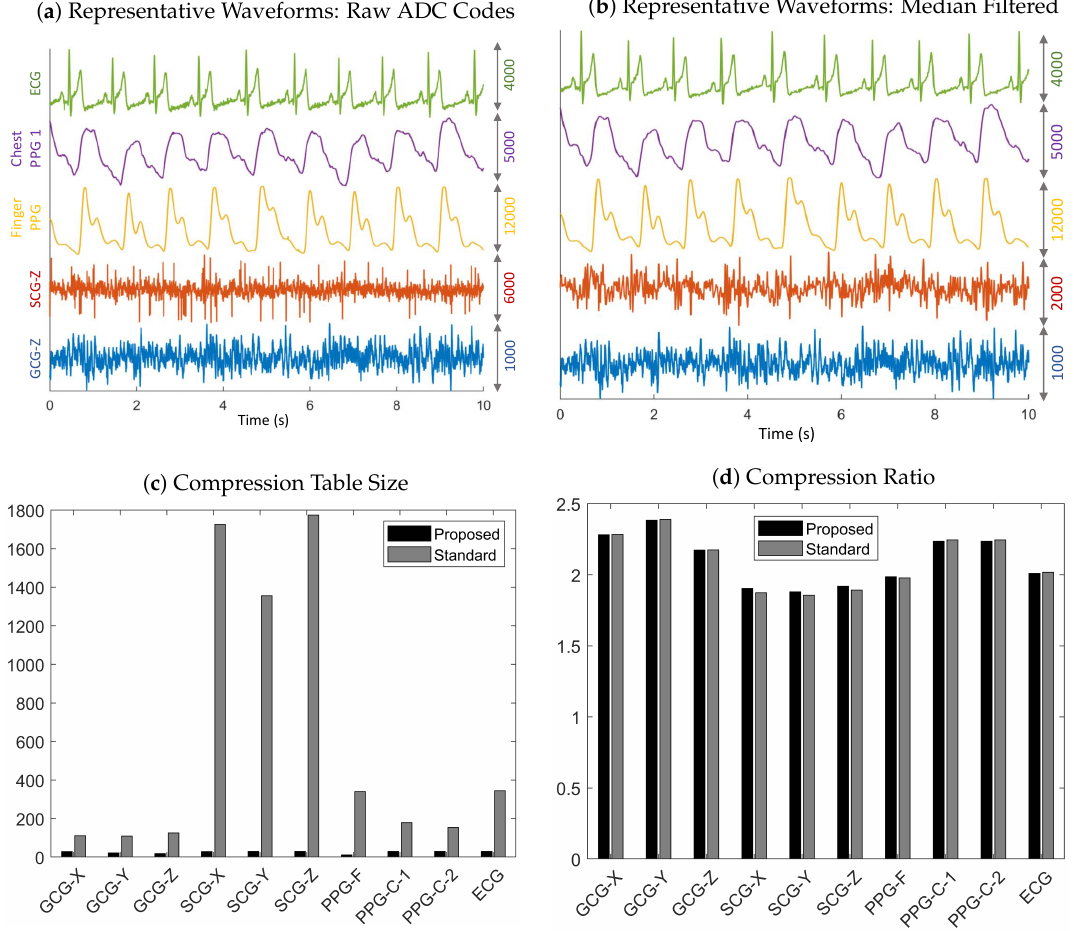
Figure 8. Representative results of data recorded from Subject 4 at 3200 Hz. ( a ) Ten-second trace of raw ADC codes for ECG, chest PPG, finger PPG, SCG-Z, and GCG-Z data. ( b ) Filtering with a seventh-order median filter reveals the underlying signal in the electronic noise corrupted raw SCG-Z signal. ( c ) Compression table sizes for the standard and proposed methods. ( d ) Compression ratios for the standard and the proposed